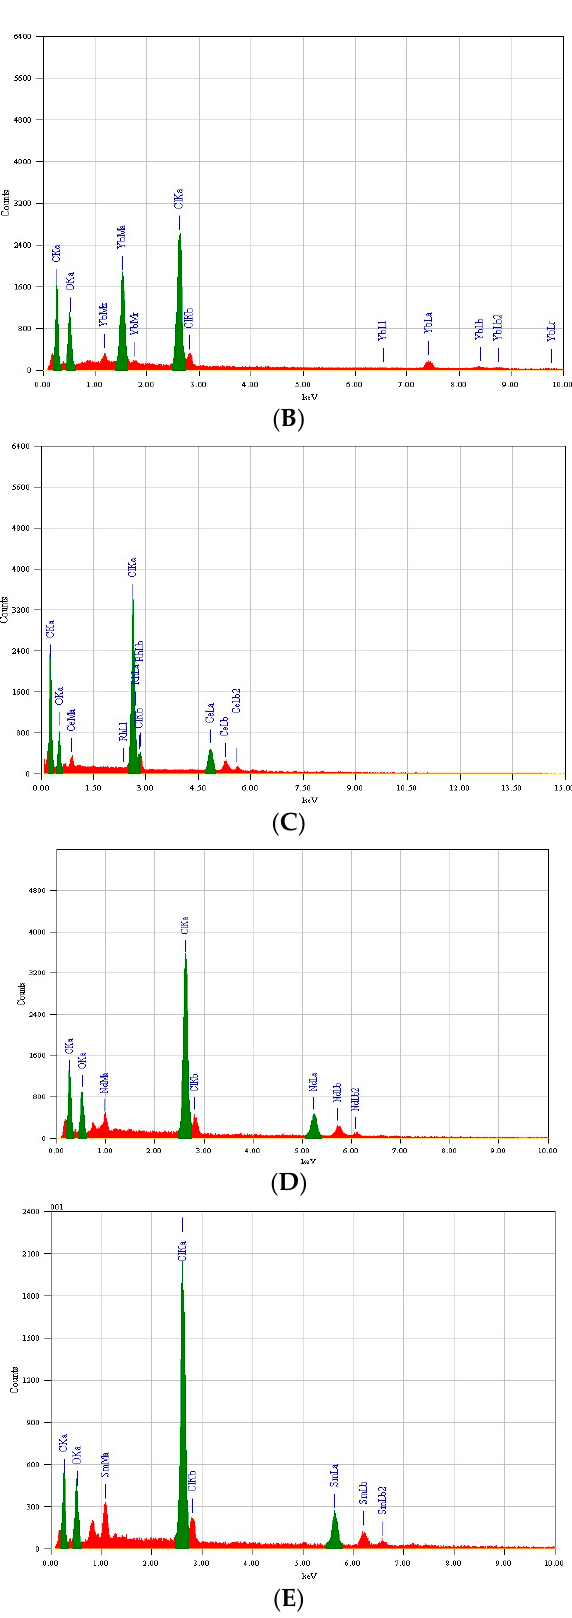
Figure 5. ( A ). EDX free adrenaline spectrum. ( B ). EDX spectrum of [Y 2 (Adr) 2 (H 2 O) 8 ]Cl 3 ·8H 2 O adduct. ( C ). EDX spectrum of [Ce(Adr) 2 (H 2 O) 2 ]Cl 3 ·10H 2 O adduct. ( D ). EDX spectrum of